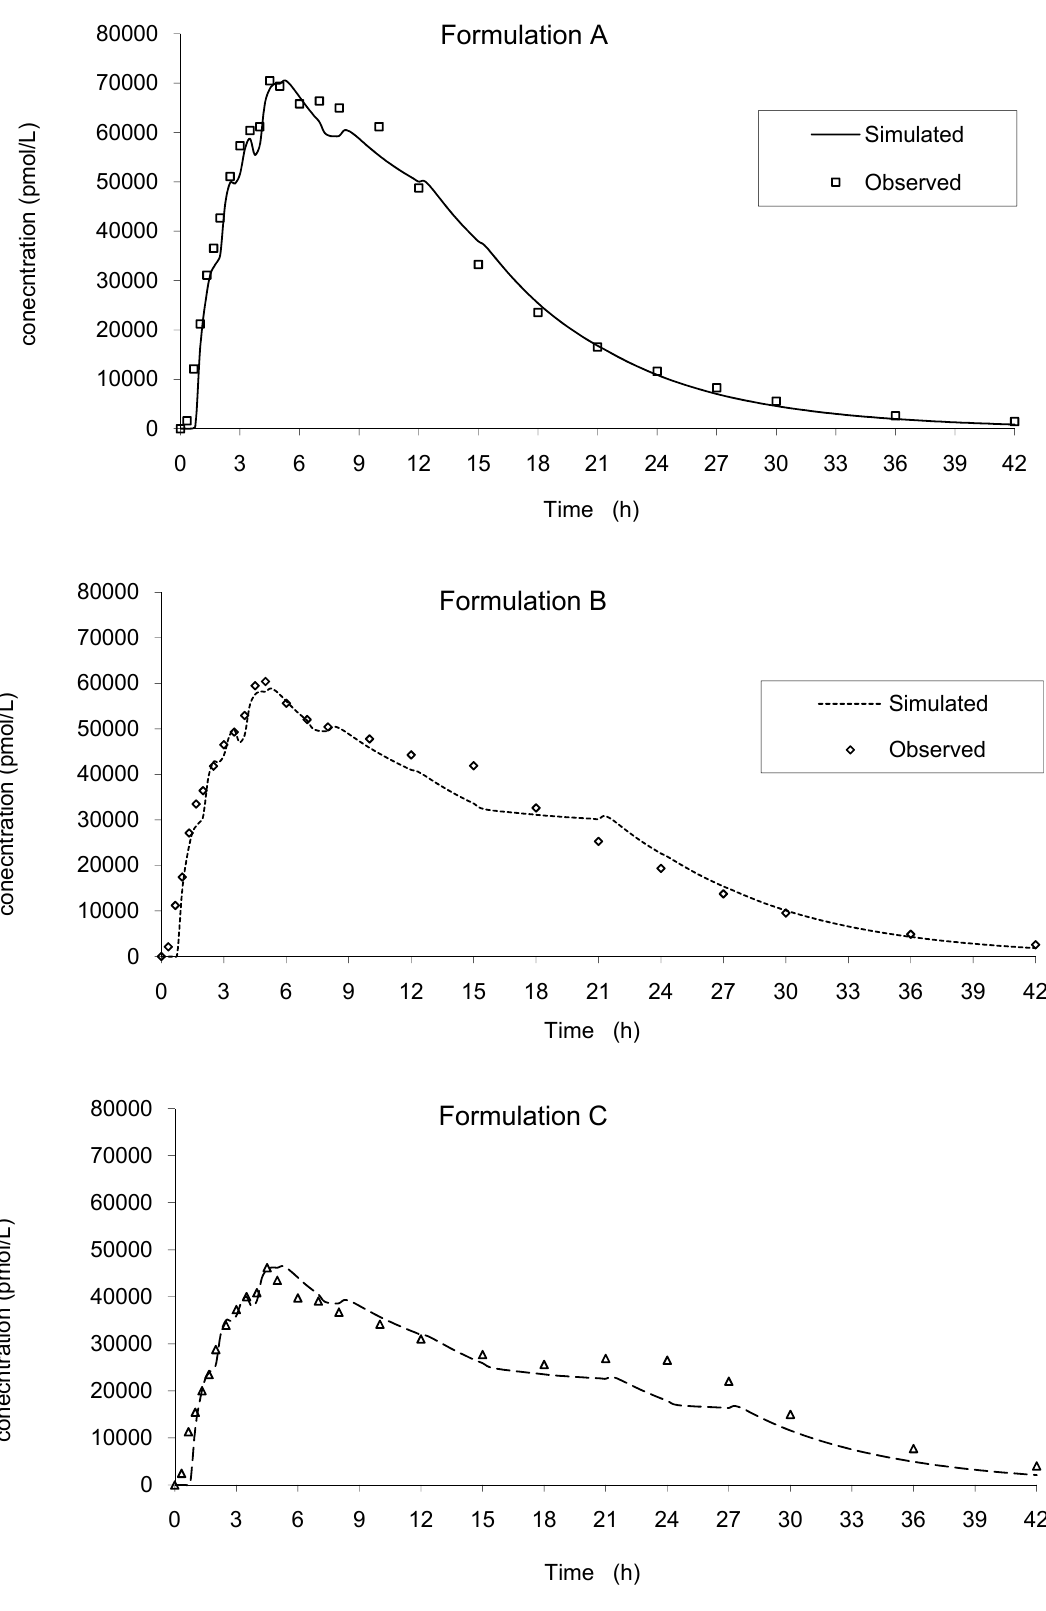
Figure 8. Simulated mean curves obtained based on IVIVC (lines) vs . observed mean values (square = formulation A , diamond = formulation B and triangle = formulation C ): internal